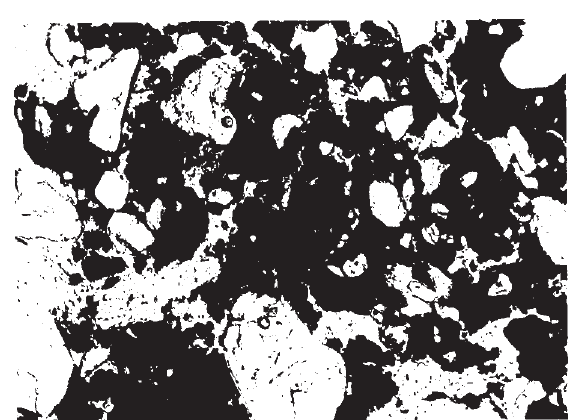
Figura 4. Microagregados formando rede de microporos comunicantes no horizonte AB do perfil sob mata nativa (XPL).